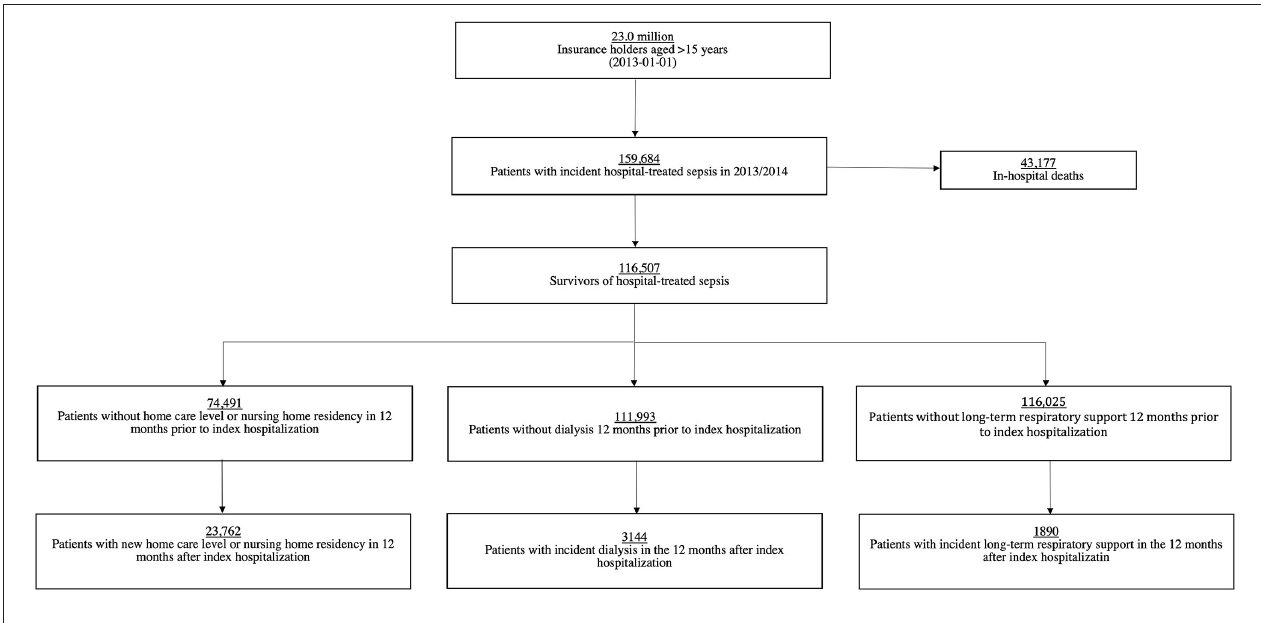
FIGURE 1 | Flow of study inclusion.